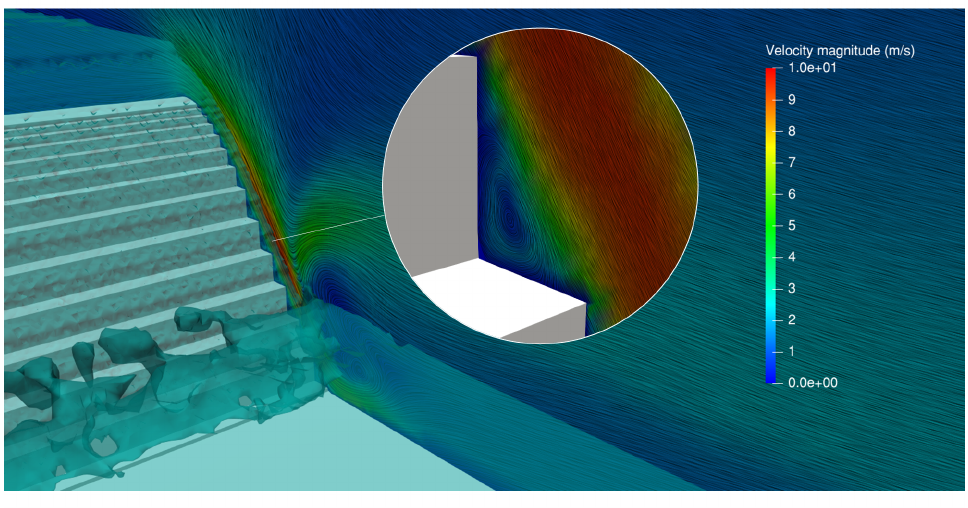
Figure 10. Local structure and speed of the water flow along the stair-step profile of the secondary